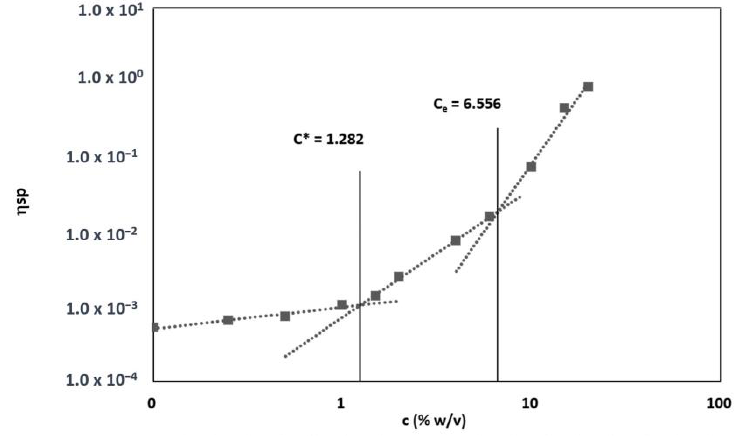
Figure 3. Specific viscosity dependence of specific ( η sp ) for Biofiber polymer solutions at 35 °C.